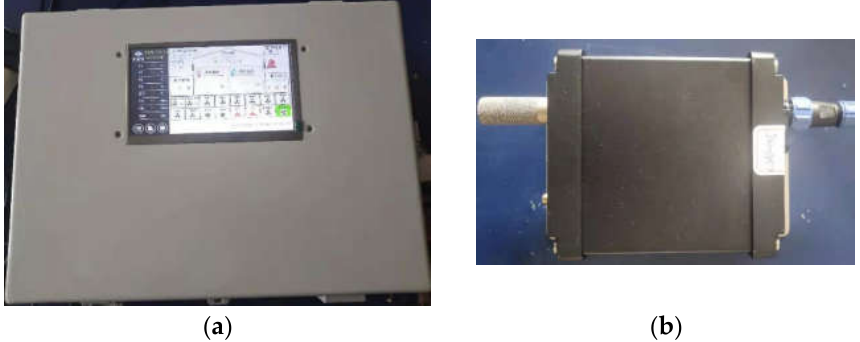
Figure 9. The shape of the controller and the acquisition node. Figure ( a ) is the controller, figure ( b ) is the acquisition node.